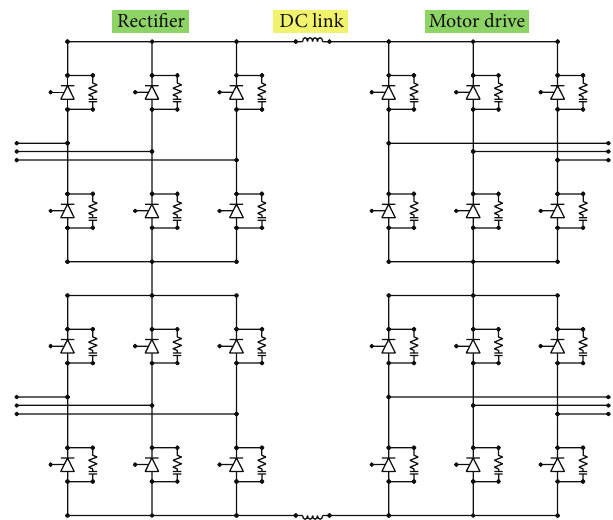
Figure 9: The model of the propulsion motor